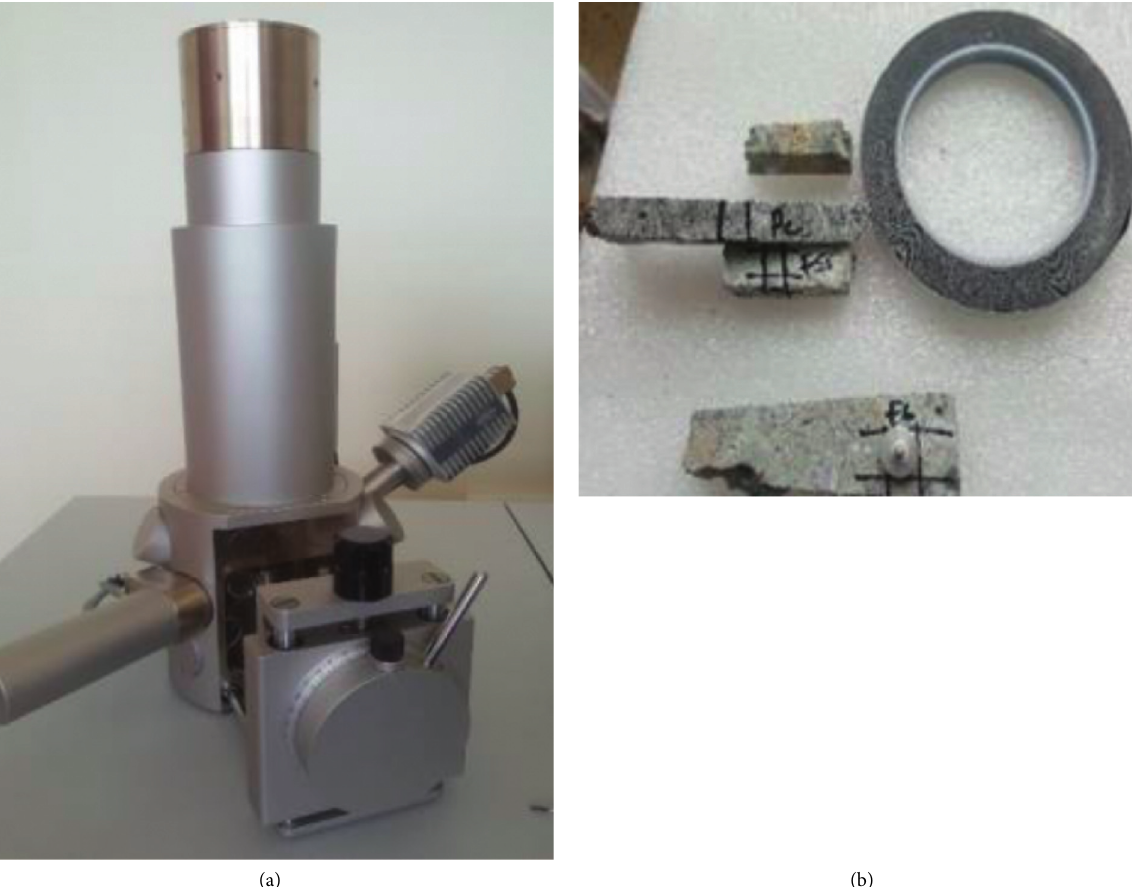
Figure 7: Microscopic morphology testing using a scanning electron microscope. (a) Variable SEM equipment. (b) Sample preparation for SEM.